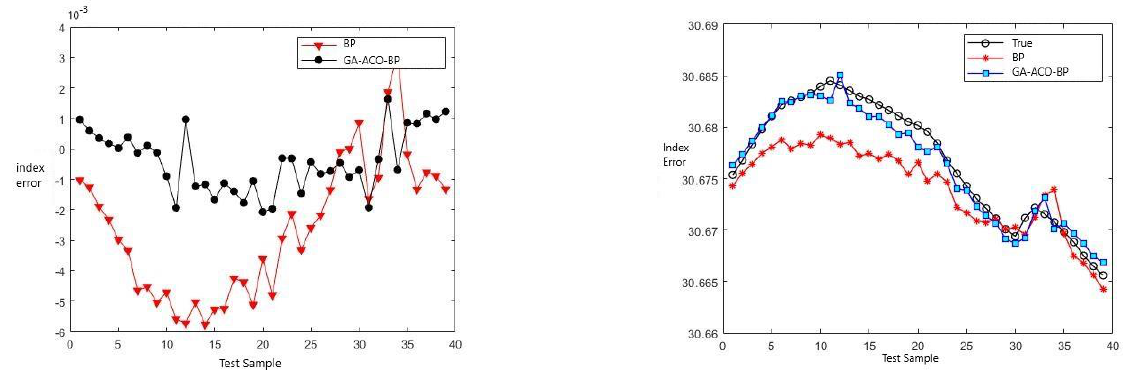
Figure 7. Latitude prediction error and comparison (GA – ACO – BP).